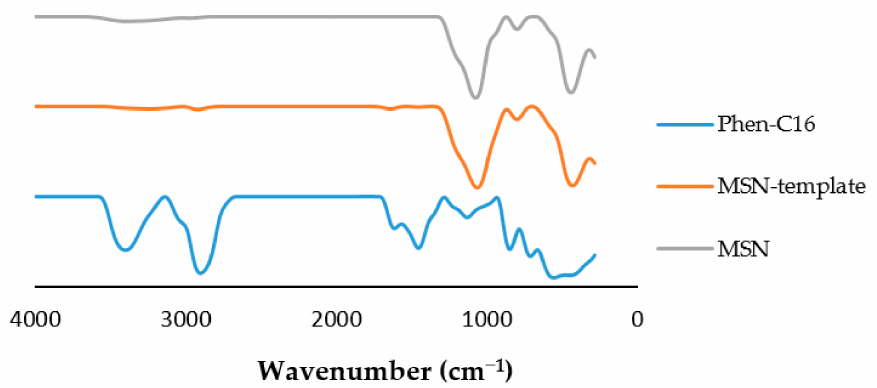
Figure 2. FTIR spectra of the synthesized template and mesoporous silica nanoparticles (MSNs) before and after removal of